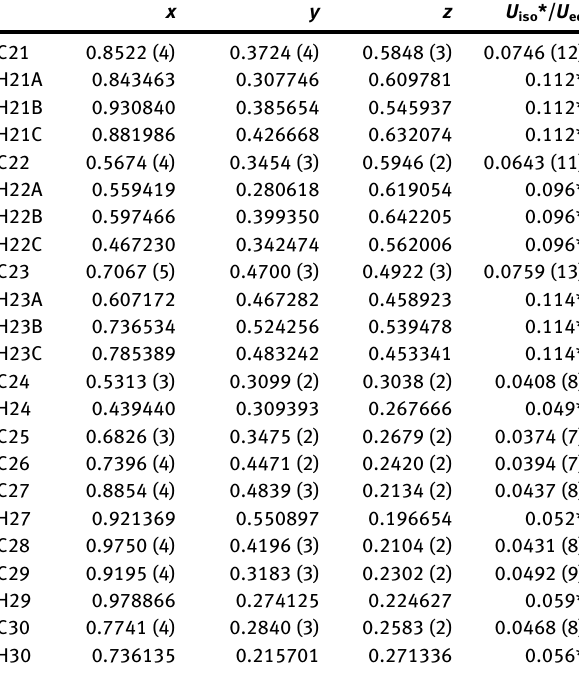
Table  : Fractional atomic coordinates and isotropic or equivalent isotropic displacement parameters (Å 